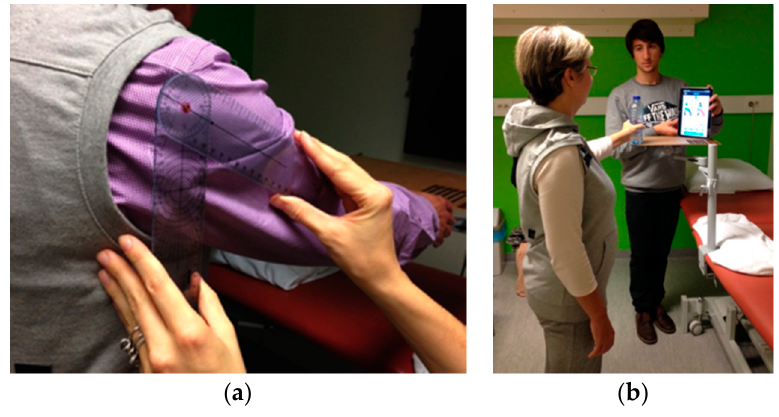
Figure 11. Task Execution: ( a ) Standardized calibration of arm movement with goniometer; ( b ) The subject is performing task 4, lifting the bottle to the board.